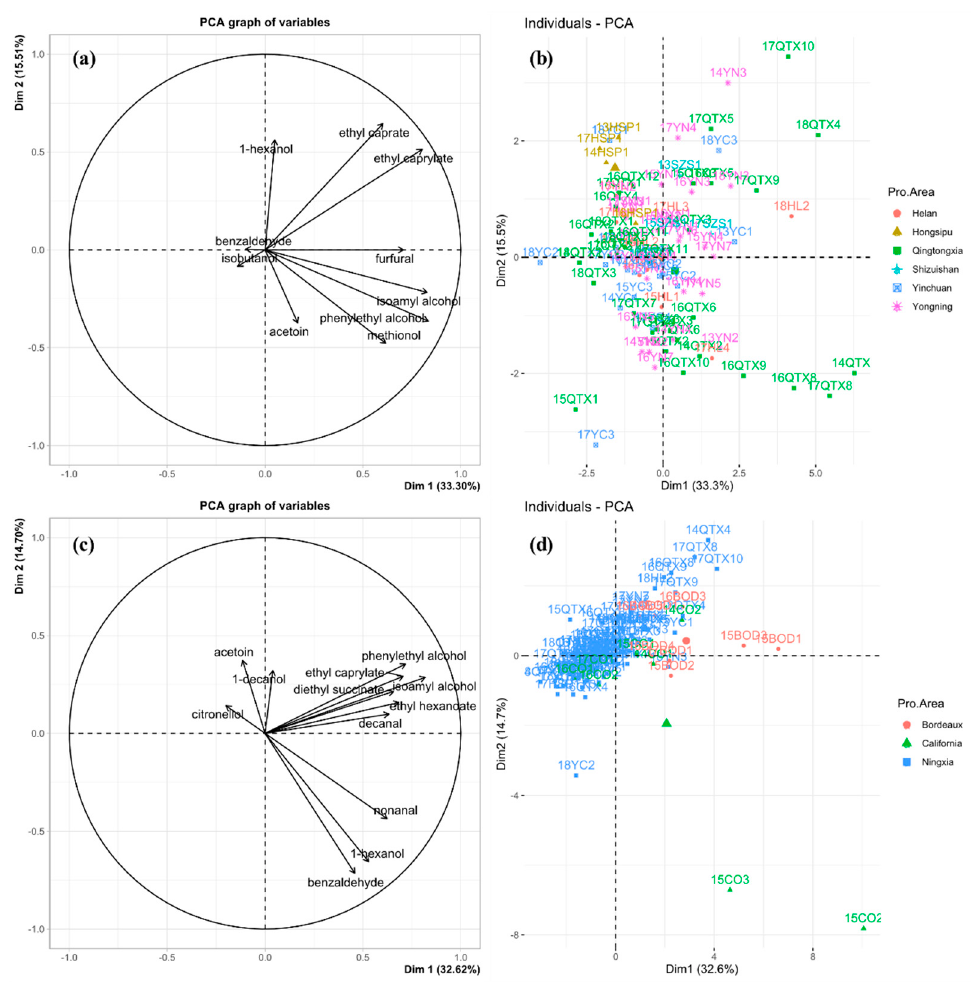
Figure 3. PCA (principal components analysis) scores plot for wines based on volatile compounds of six sub-regions of Ningxia ( a ) and three wine-producing regions ( c ). PCA loadings plot of volatile compounds of six sub-regions of Ningxia ( b ) and three wine-producing regions ( d ). The first (PC1, 33.3%) and second (PC2, 15.5%) principal components (Figure 3a,b),